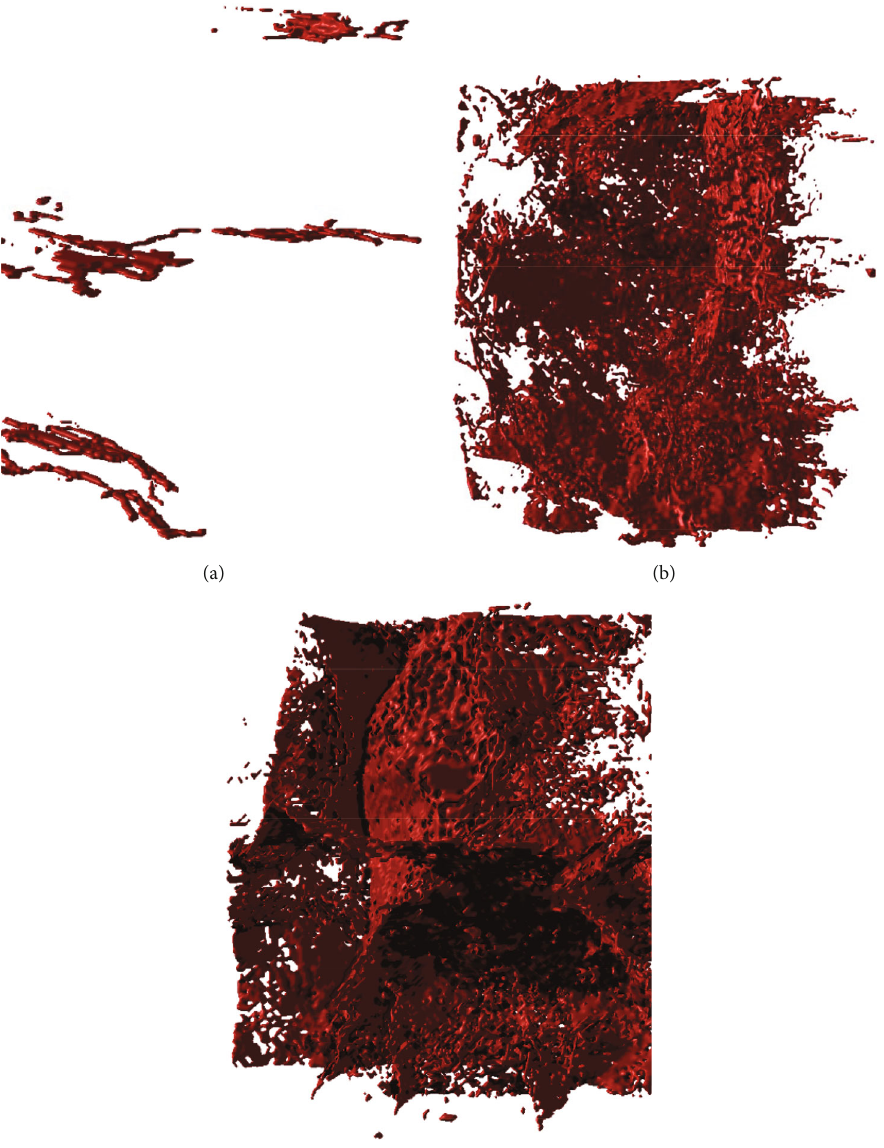
Figure 12: Three-dimensional pore scale model: (a) undisturbed sample, (b) one cycle, and (c) two